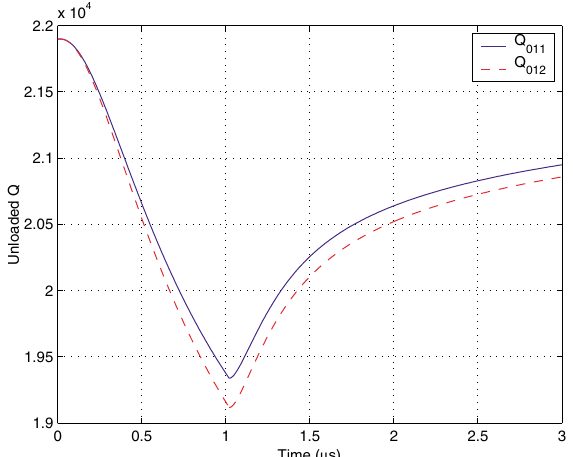
FIG. 14. (Color) Magnitude and phase of the reflected signal for both TE and TE modes with respect to the input signal due to the change in Q 0 011 012 TE 012